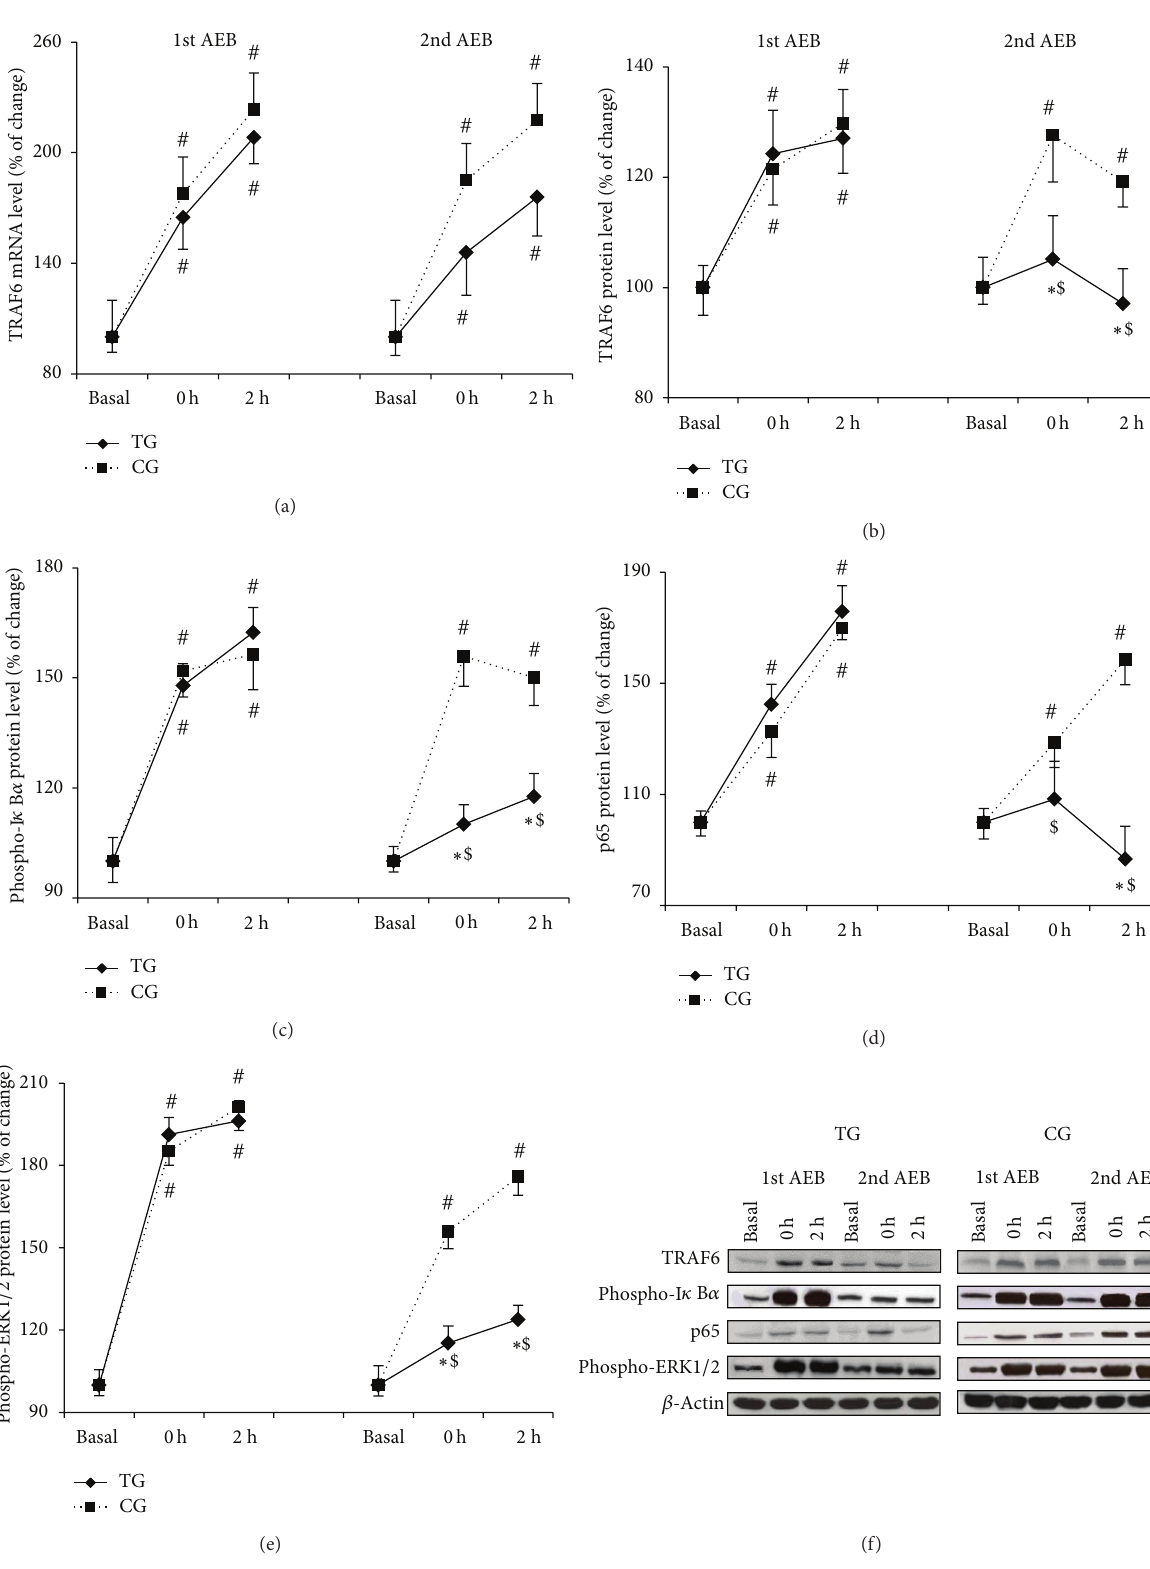
Figure 3: Training reduces TRAF6 and p65 protein overexpression and I 𝜅 B 𝛼 and ERK1/2 phosphorylation after eccentric exercise. TRAF6 mRNA (a), TRAF6 protein (b), phospho-I 𝜅 B 𝛼 (c), p65 (d),and phospho-ERK1/2 (e) protein levels after thefirstand thesecond acute eccentric bout (AEB) for training group (TG, solid line) and control group (CG, dotted line) and representative Western blots (f). Mean ± SEM. ∗ 𝑃 < 0.05 versus CG; # 𝑃 < 0.05 versus basal value, same group; $ 𝑃 < 0.05 versus 1st acute eccentric bout, same